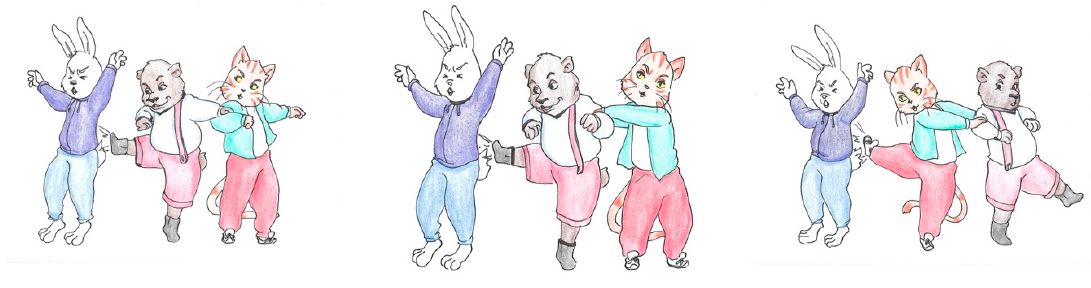
Figure A19. ORC stimulus 4.